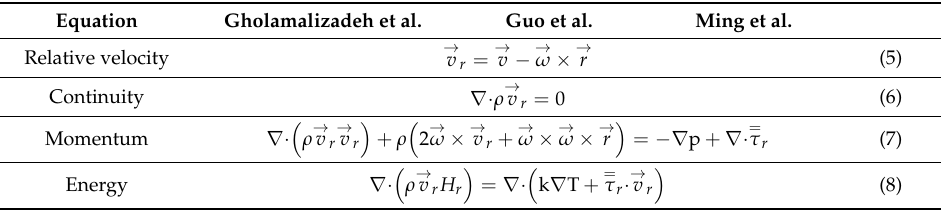
Table 5. Equations of motion.